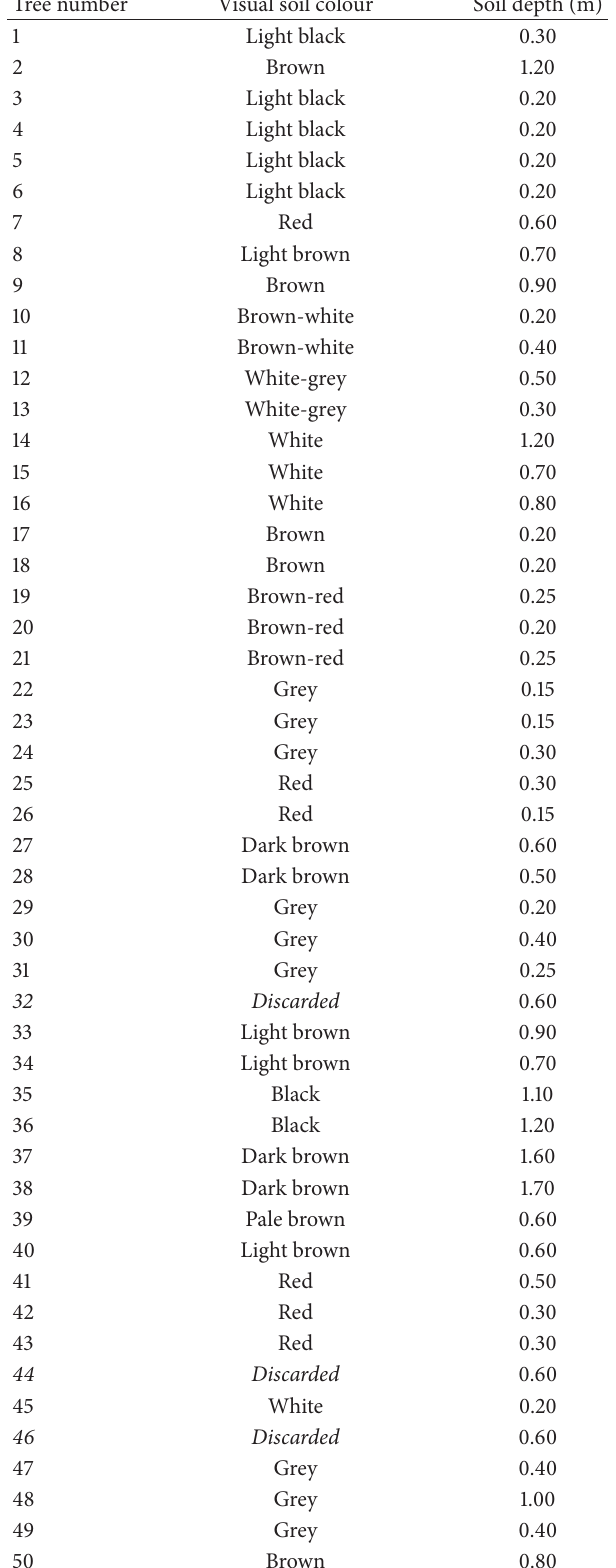
Table 2: Characteristics and fertility levels of the topsoil (0–20 cm) for the selected trees.